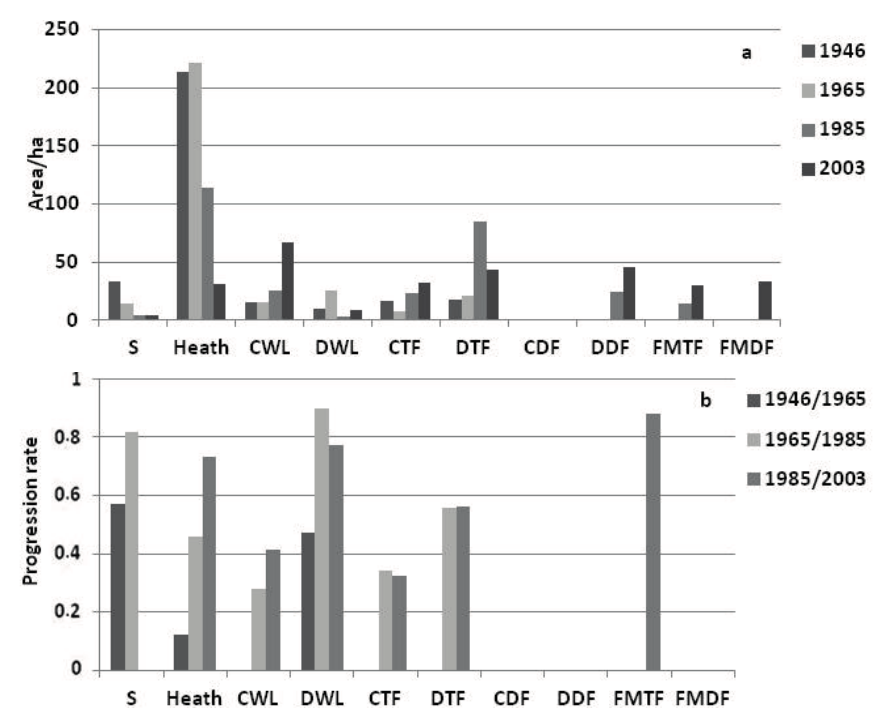
Figure 3. ( a ) Changes in area (ha) of the different dynamic stages between 1946 and 2003. ( b ) Changes in change rate for each vegetation category calculated from the transition matrices of 1946–1965, 1965–1985, and 1985–2003 (e.g., the Heathland change rate is 0.13 between 1946 and 1965 and 0.73 between 1985 and 2003). Bare soil (S), Heathland (Heath), Conifer woodland (CWL), Deciduous woodland (DWL), Conifer thin forest (CTF), Deciduous thin forest (DTF), Conifer dense forest (CDF), Deciduous dense forest (DDF), Mixed forest thin forest (FMTF), Mixed forest dense forest